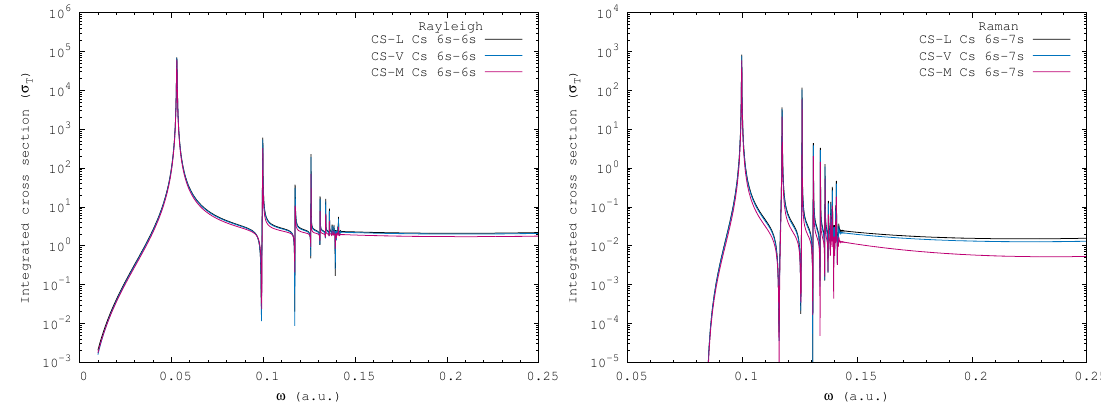
Figure 2. Rayleigh and Raman scattering cross sections for the ground state of cesium calculated using the complex scaling (CS) method. We compare cross sections for different forms of the dipole operator, these being the length (L) gauge, velocity (V) gauge, and modified length (M) defined by Equation (15). The difference between the length and velocity gauge cross sections is due to the use of an l -dependent potential.